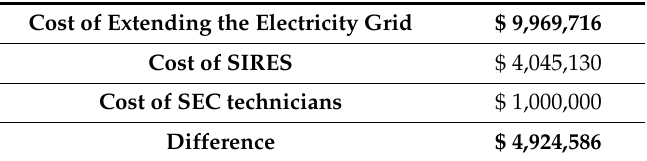
Table 11. Comparison of costs, in Chilean